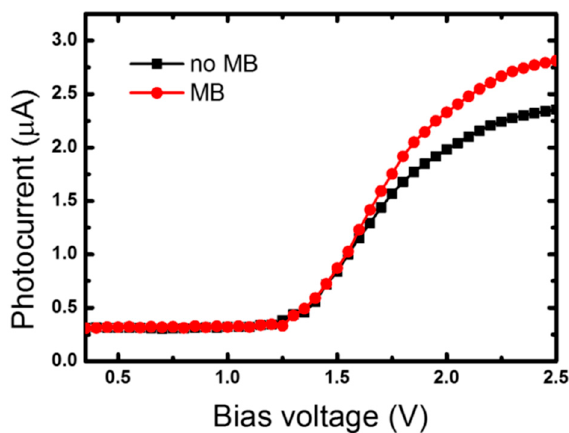
Figure 2. Photocurrent versus bias voltage for area with and without magnetic